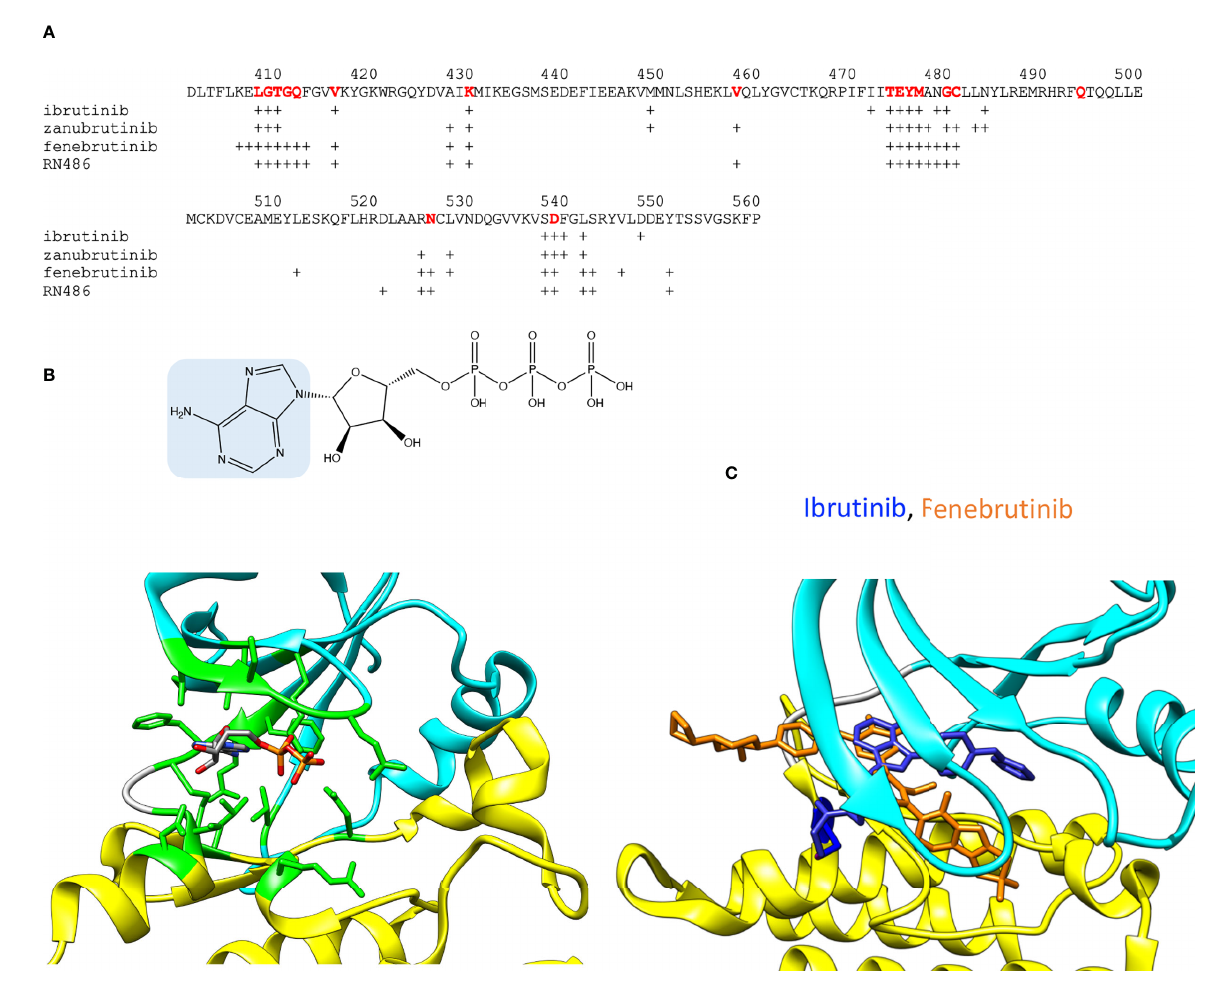
FIGURE 2 | ADP and inhibitor binding. (A) BTK sequence indicating amino acids within 5 Å radii from ADP or inhibitors. For ATP binding, residues corresponding to interacting amino acids in BTK are shown in red. Crosses indicate the interacting amino acids in inhibitor complexes. (B) Upper panel : Chemical structure of ATP, adenine is highlighted in blue. Lower panel : ADP bound to ITK kinase domain (4m15). Residues within 5 Å from ADP are in green. Atoms in the ADP are colored based on the elements, carbon gray, nitrogen blue, oxygen red, and phosphorus orange. (C) Differences in the binding modes of the covalent inhibitor, ibrutinib (blue, 5p9j), and non-covalent inhibitor, fenebrutinib (orange, 5v fi ), to BTK. C481 is in